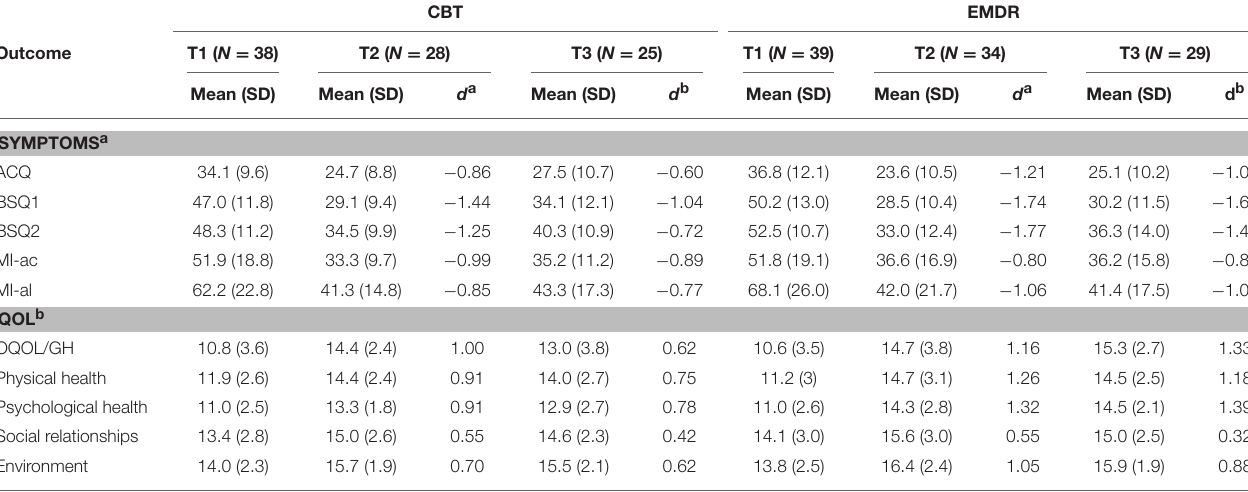
TABLE 2 | Observed outcome means (standard deviation) for both treatment groups EMDR and CBT for baseline (T1), after treatment (T2), and 3 months follow up (T3). CBT EMDR